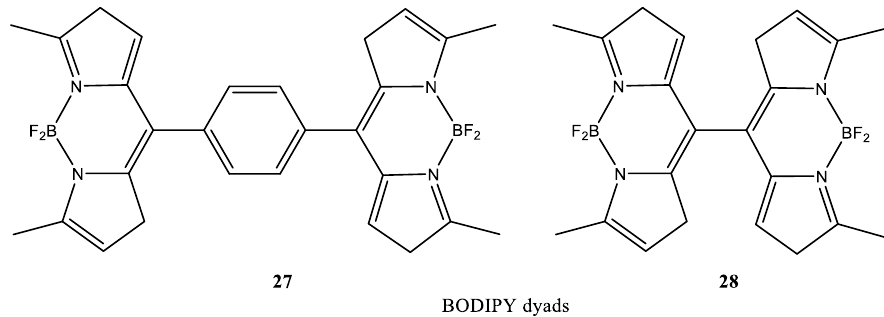
Figure 5. New approach to structurally constrained BODIPY dyes.